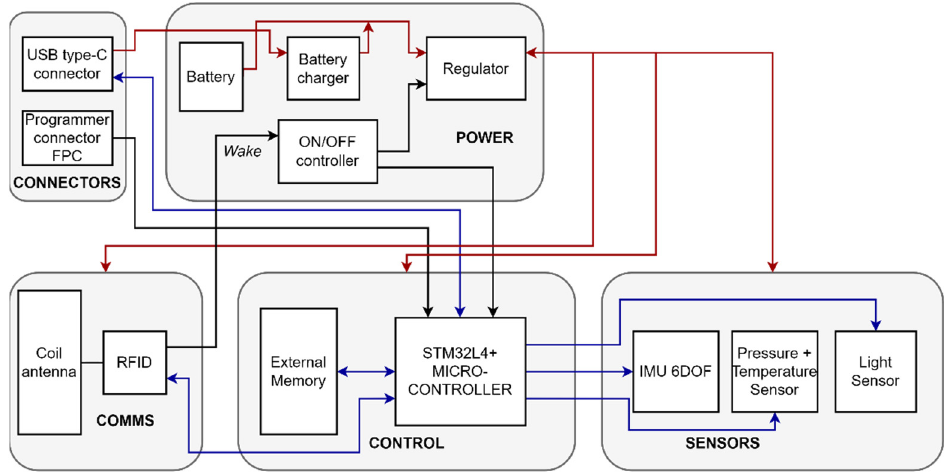
Figure 1. System block diagram for the device hardware.